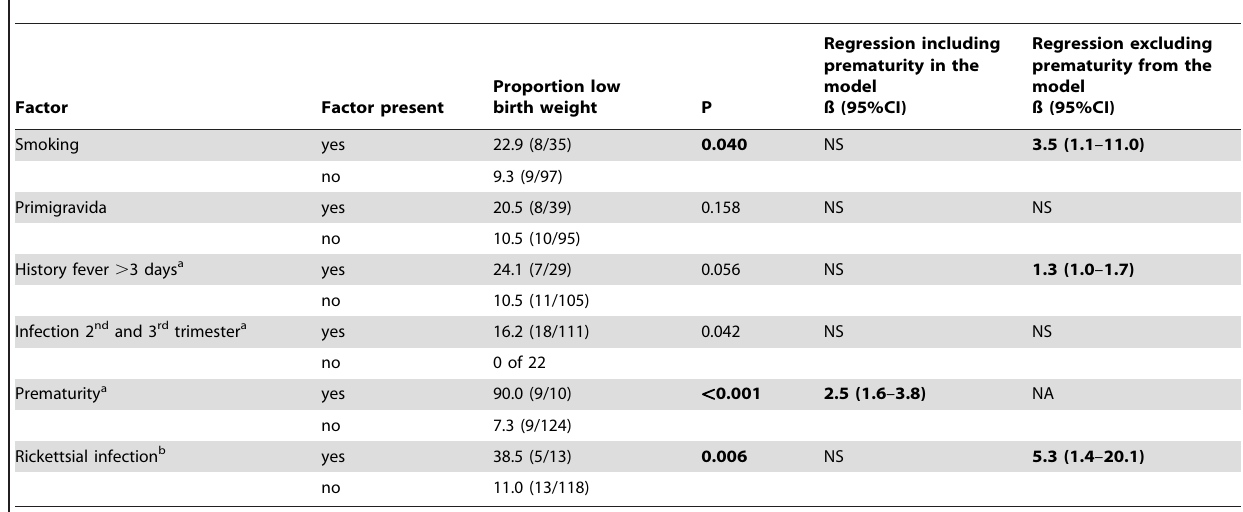
Table 5. Factors associated with low birth weight on univariate and regression